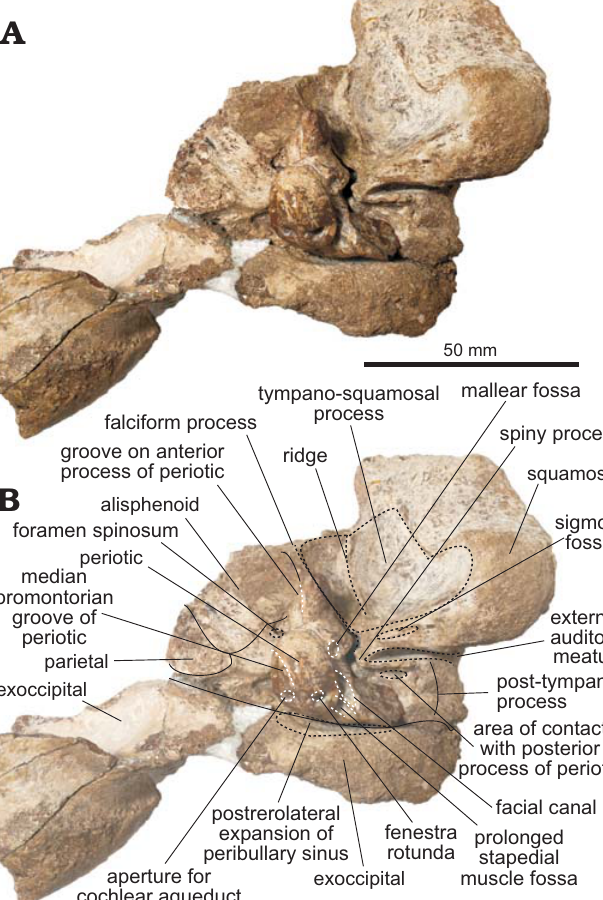
Fig. 4. Partial skull and periotic in situ of the holotype of the platanis- toid dolphin Aondelphis talen gen. et sp. nov. (MPEF-PV 517) from the early Miocene Gaiman Formation, Bryn Gwyn, Patagonia, Argentina; left side in ventral view. Dashed lines indicate specific structures (black, skull; white, periotic), whilst continuous lines indicate sutures. It should be noted that the position of the periotic does not take into account the volume that may have occupied the peribullary sinus and other soft tissue structures. Photograph ( A ), photograph with explanations ( B